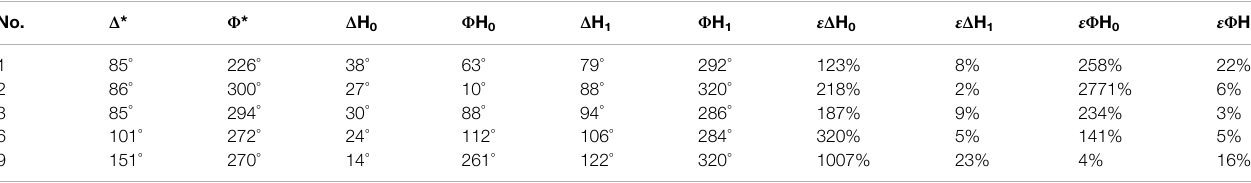
TABLE 2 | Hypotheses test using distance and azimuth statistics. Low error con fi rms hypotheses H 1 .